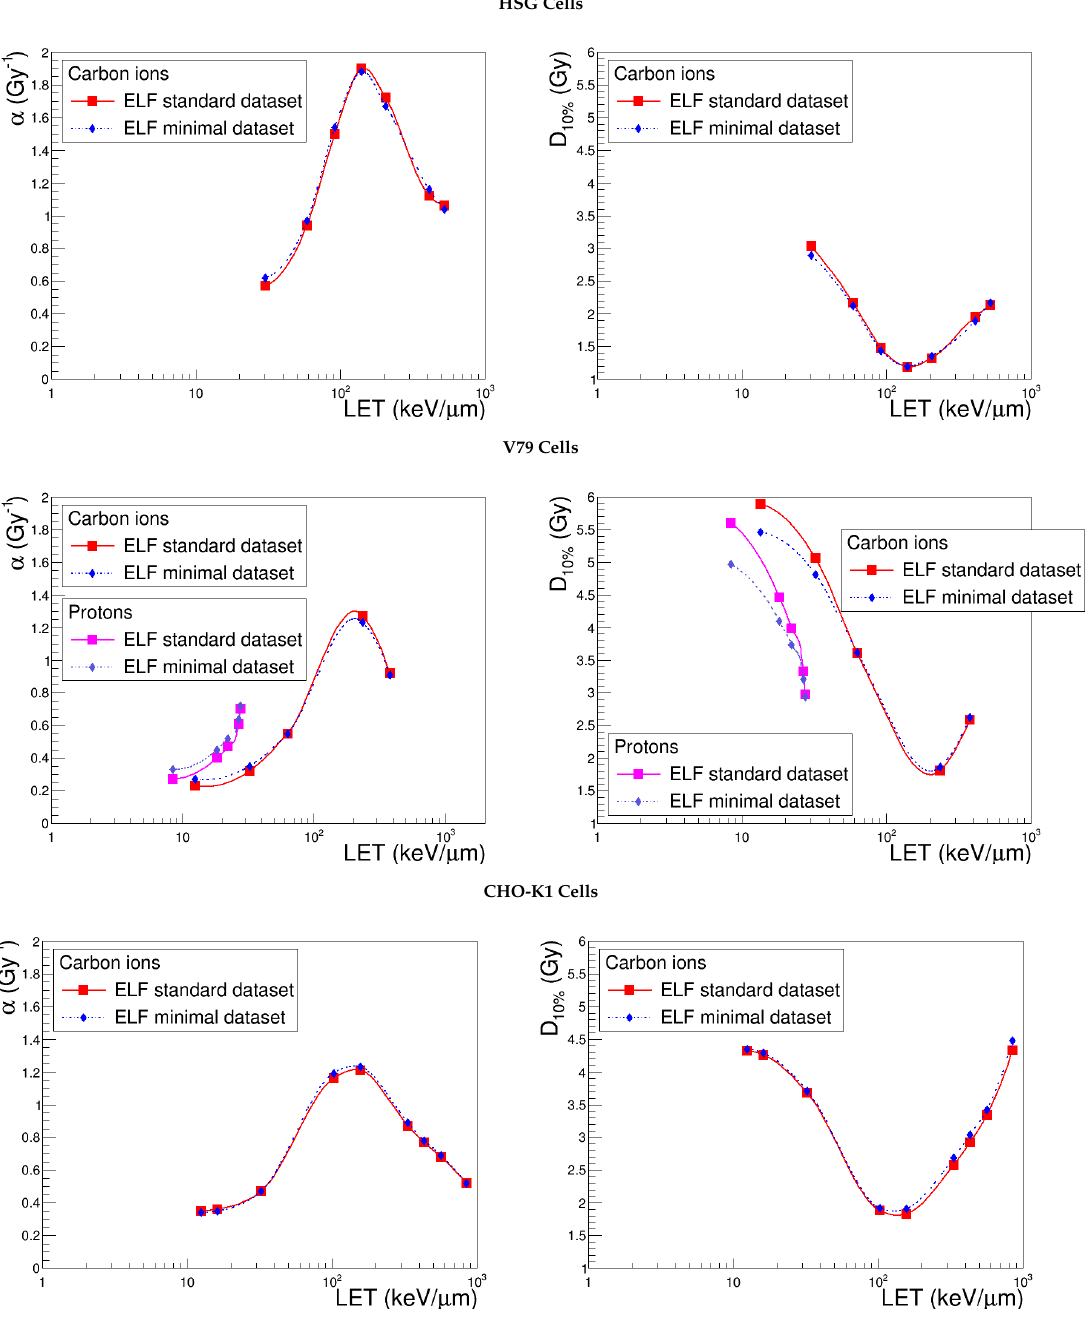
Figure 6. α and D 10% predicted by NanOx for the standard configuration (red curve) and optimizing the effective lethal function with only three data points (blue curve). The full symbols correspond to the LET values for which the estimates were performed, while the lines are drawn just to guide the eye and do not represent a